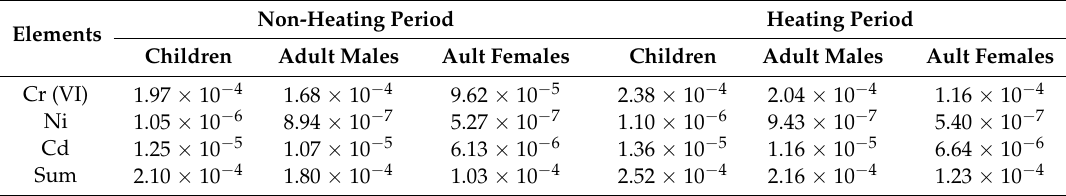
Table 11. The carcinogenic risks of heavy metals via